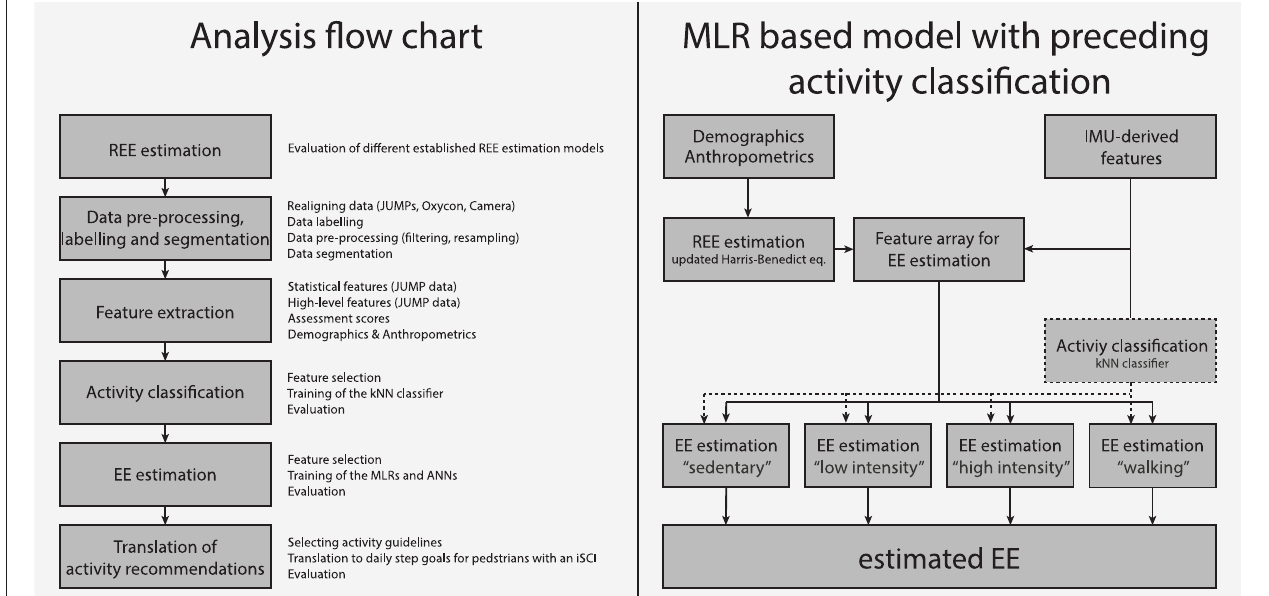
FIGURE 2 | (Left) Analysis flow chart used in this study. (Right) Overview of the different analysis steps for the MLR based model with preceding activity classification.